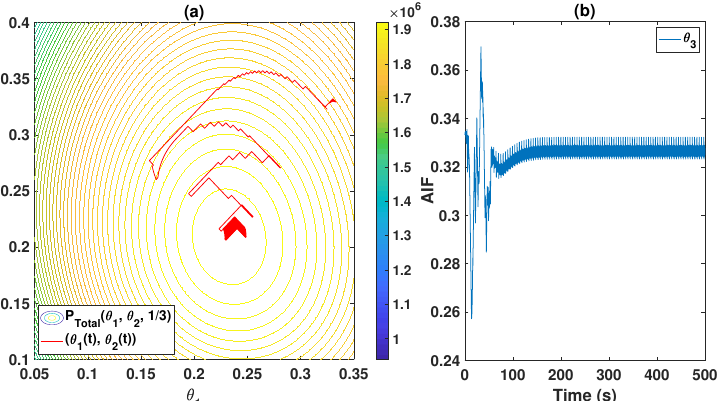
Figure 7. Convergence of the axial induction factors using the proposed distributed scheme. ( a ) For the first two turbines with, θ 3 = 1/3. ( b ) Convergence of θ 3 .